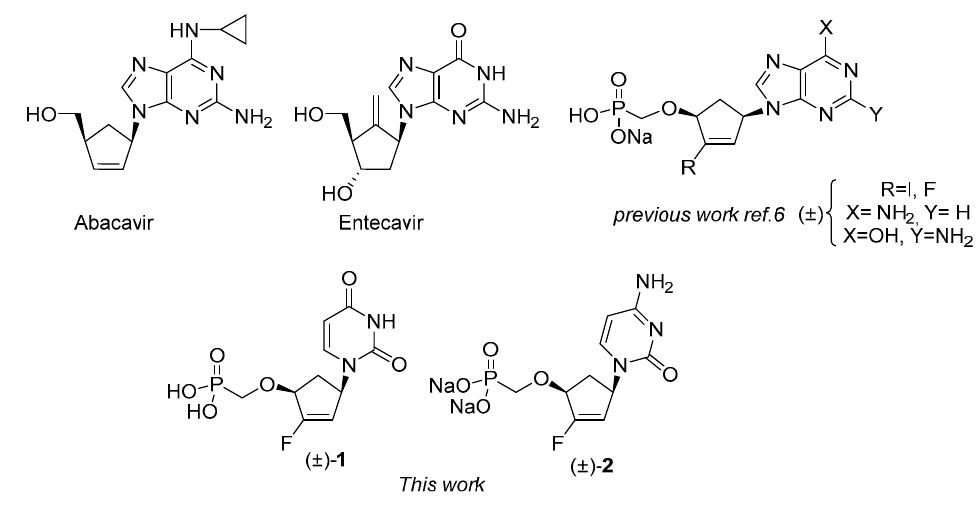
Figure 1. Example of antiviral carbocyclic nucleosides and structures of the target compounds.